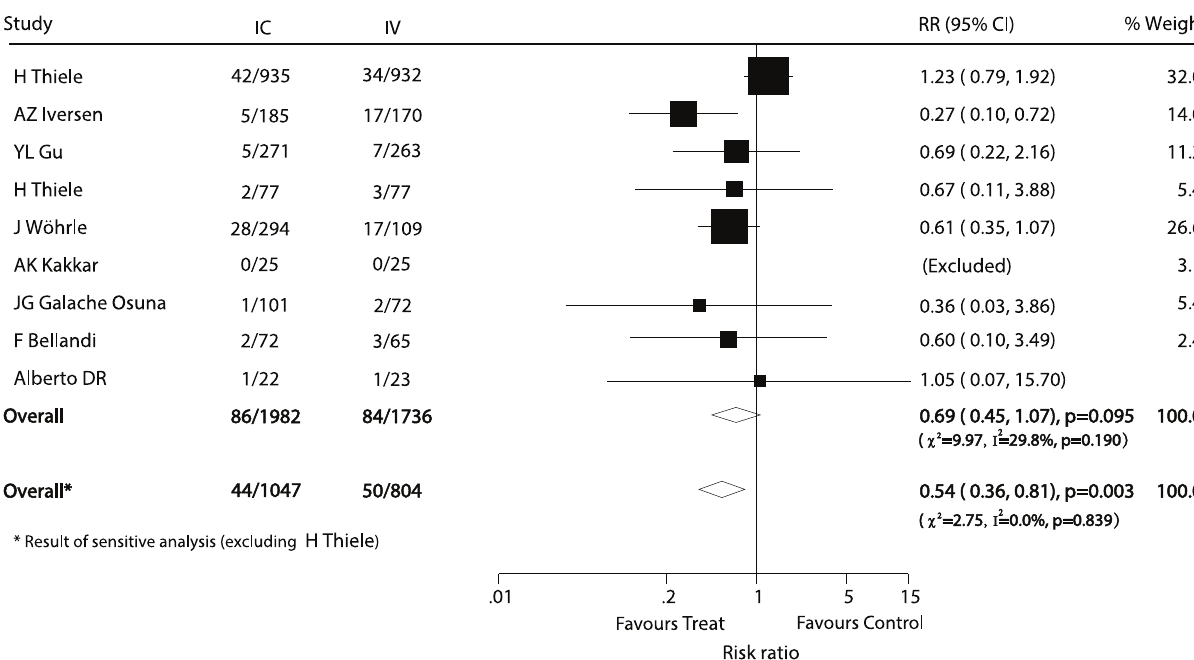
Figure 3. Effects of IC administration of abciximab on risk of total death as compared to IV therapy in patients with ACS.